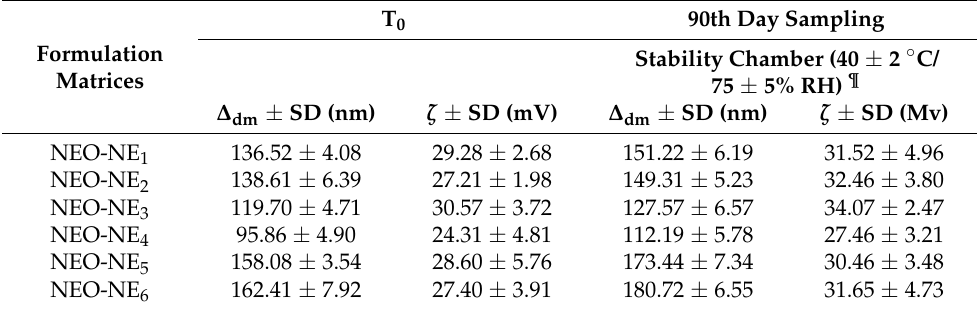
Table 5. In vitro stability evaluation of NEs stored in regulated conditions (mean ± SD, n =